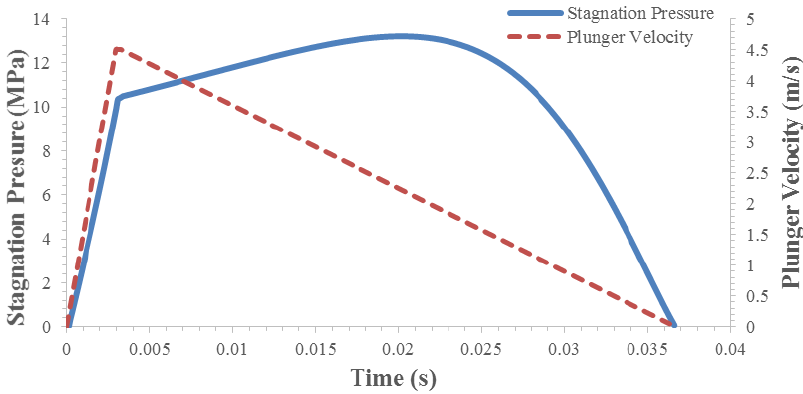
Figure 6. Pressure output as a function of theoretical plunger velocity.